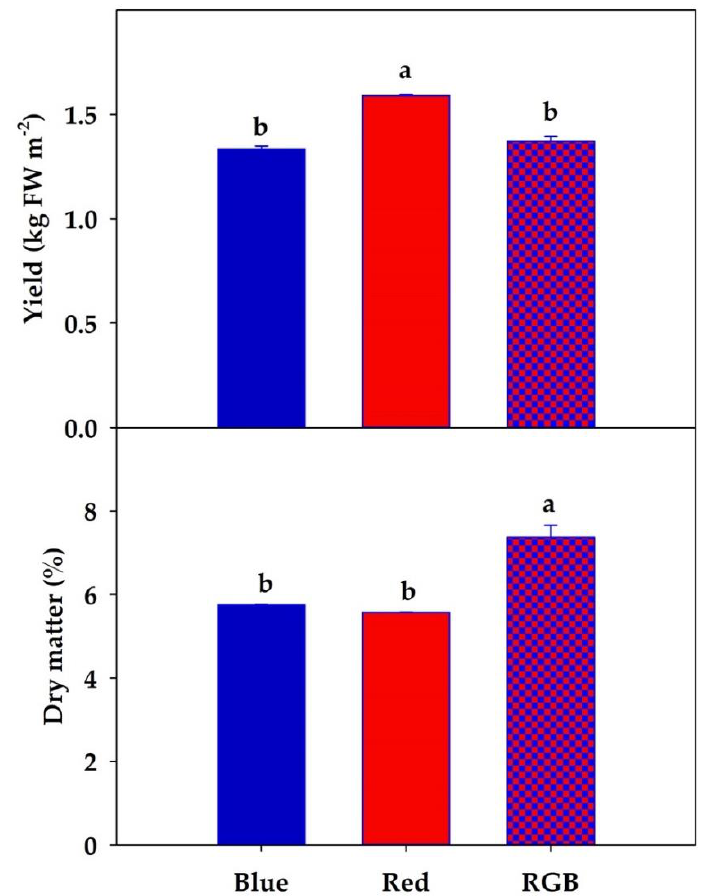
Figure 1. Fresh yield and dry matter percentage of parsley microgreens with reference to the different light treatments (red, blue and RGB). Different letters indicate significant differences according to Tukey’s HSD test ( p = 0.05). All data are expressed as mean ± standard error, n = 3. RGB: red, green-yellow, blue.